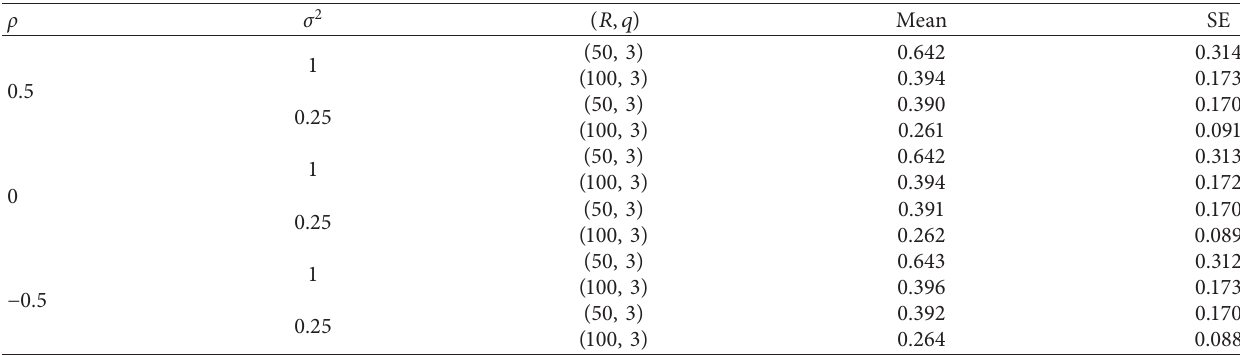
Table 4: The mean and SE of RASE for the functional coefficient β ( t ) under different